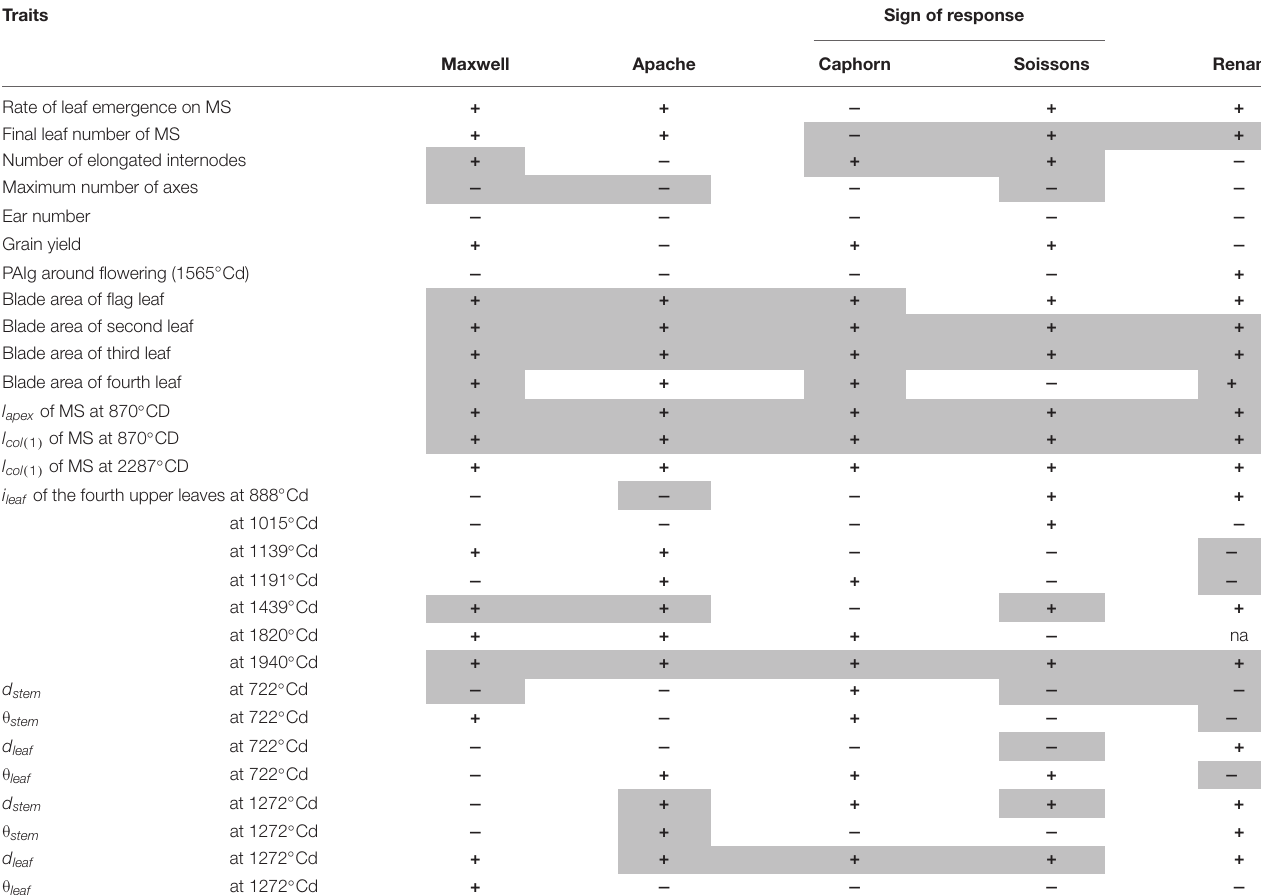
TABLE 2 | Summary of the effect of increasing row spacing on architecture variables.